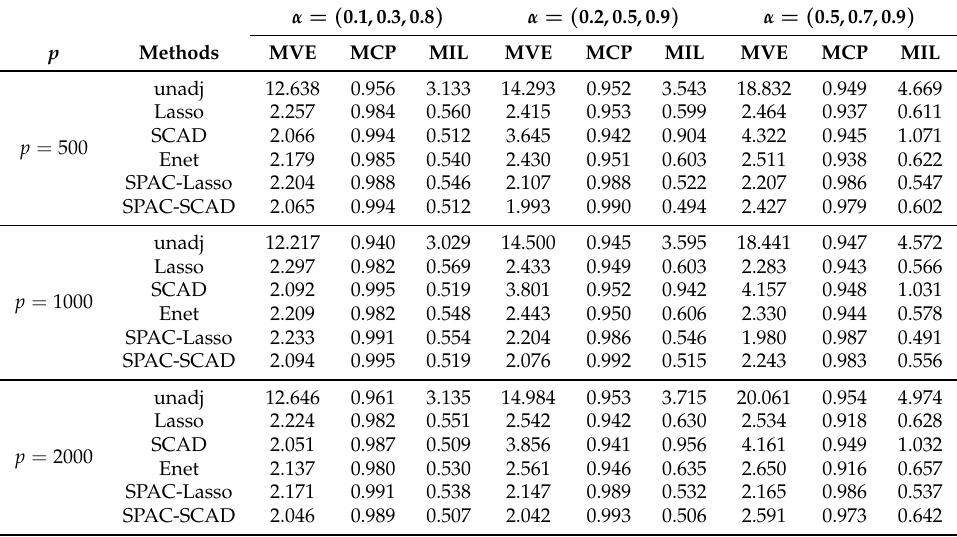
Table 3. The performance of the variance estimates and confidence intervals. α = ( 0.1,0.3,0.8